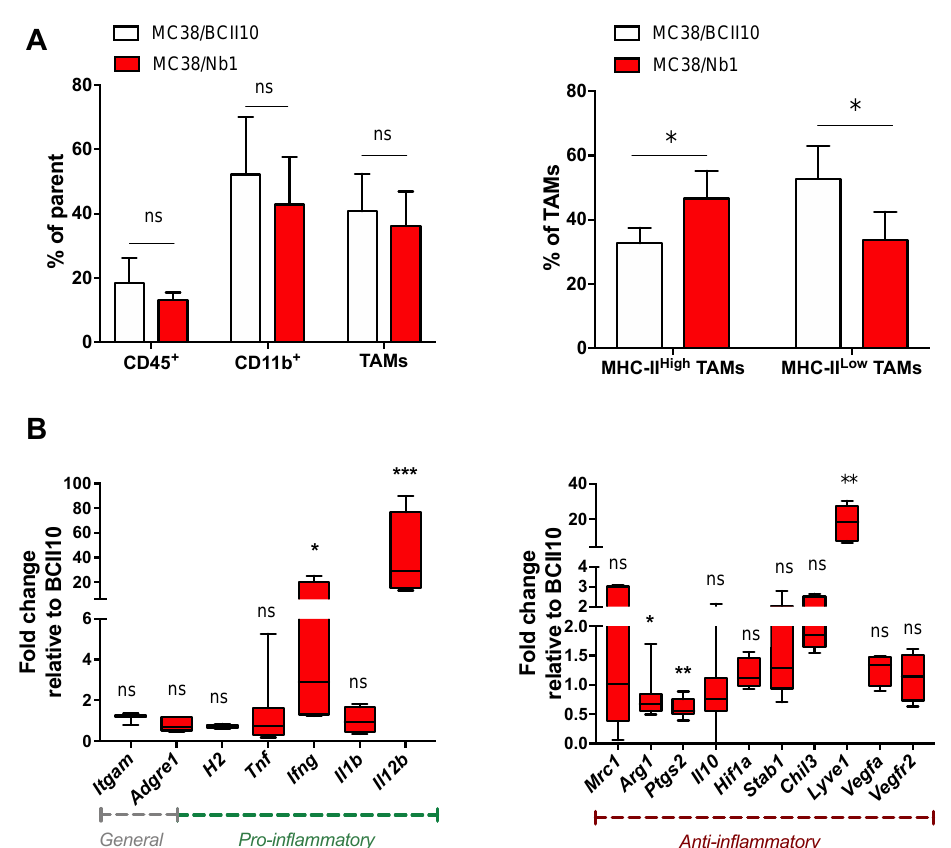
Figure 6. Production of Nb1 in the tumor microenvironment (TME) of MC38 tumors alters macrophage numbers and function. ( A , B ) MC38 / BCII10 or MC38 / Nb1 tumors were grown at the lower back of C57BL / 6 mice. Growth of MC38 tumors was monitored on a daily basis. Tumors with a size of 458 ± 40 mm 3 were isolated and reduced to single-cell suspensions. ( A ) Flow cytometry was used to determine the percentage of immune cells (CD45.2 + ), and within these immune cells, the percentage of myeloid cells (CD45.2 + CD11b + ), and within these myeloid cells, the percentage of macrophages (CD45.2 + CD11b + Ly6G − Ly6C − / low F4 / 80 + ). Macrophages were further subdivided into MHC-II low or MHC-II high cells. The bar graphs show the percentage of cells and summarize the results of two independent experiments ( n = 2, mpc = 6). Statistical analysis was performed by the Student’s t -test and asterisks represent a p -value < 0.05 (*). ( B ) mRNA was isolated from macrophages sorted from tumors as CD45.2 + CD11b + Ly6G − Ly6C − / low and F4 / 80 + cells. RT-qPCR was performed to determine the expression of Itgam (CD11b), Adgre1 (F4 / 80), H2 (MHC-II), Tnf , Ifng , Il1b , Il12b , Mrc1 (CD206), Arg1 , Ptgs1 (Cox2), Il10 , Hif1a , Stab1 , Chil3 ( Ym1 ), Lyve1 , Vegfa and Vegfr2 . The box and whisker graph shows the range, mean and standard deviation of the fold in- or decrease in expression of the evaluated markers. The box and whisker graph summarizes the results of two independent experiments ( n = 2, mpc = 6). Statistical analysis was performed by the Student’s t -test and asterisks represents p < 0.05 (*), p < 0.01 (**) and p < 0.001 (***).